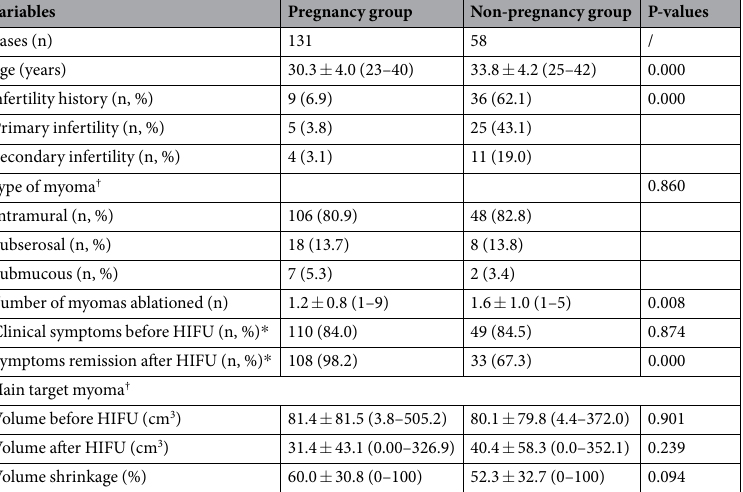
Table 5. Characteristics between pregnancy group and non-pregnancy group. * Whether clinical symptoms were relieved according to patient’s subjective evaluation. † In cases of multiple myomas, these findings refer to only the largest